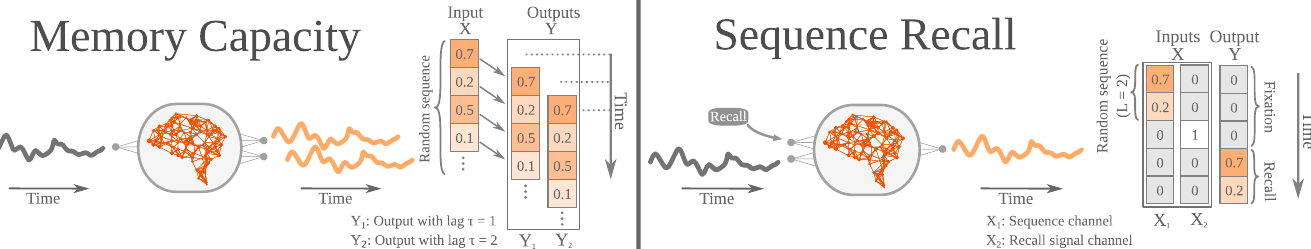
Fig 6. Cognitive tasks. Schematic representation of the tasks and the input/output data structure for each of the cognitive tasks used to evaluate the performance of the BioESNs. Left: Memory capacity (MC) task, where the network receives a stream of random values as single input X and has several independent outputs Y (for simplicity, the example shows only two. Each output is memorized by an independent output neuron of the network and is supposed to recall the input at a specific time lag τ . The BioESNs were trained with 4000 time steps and tested on the subsequent 1000. Right: One trial of the sequence recall task. The network receives inputs X 1 , X 2 coming from a random sequence and a recall signal channel, respectively. There is only one output neuron, which after the recall signal channel indicates it (i.e., X 2 = 1) is supposed to reproduce the input received in the previous L steps, i.e., the pattern length parameter determining the difficulty of the task (for simplicity, in the scheme L = 2). The BioESNs were trained with 800 trials and tested on 200 trials. The score was computed considering only the recall phase in order to avoid inflation of the metric, given that the fixation periods were much easier to perform